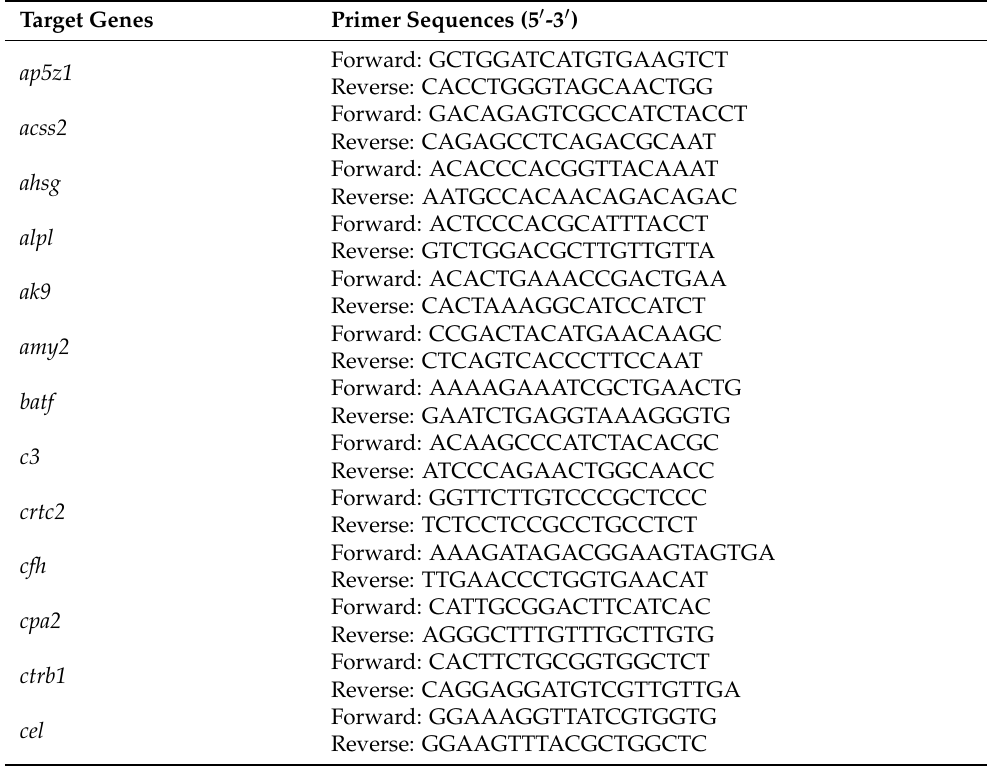
Table 4. Primers used for qRT-PCR in the present